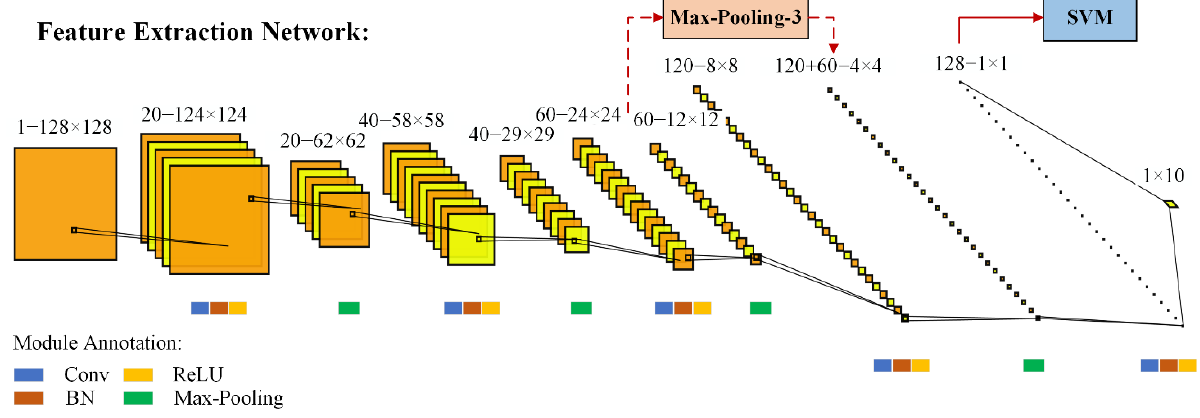
Figure 2. The architecture of Figure 2. the architecture of FEN. Table 1. The network configuration of FEN.